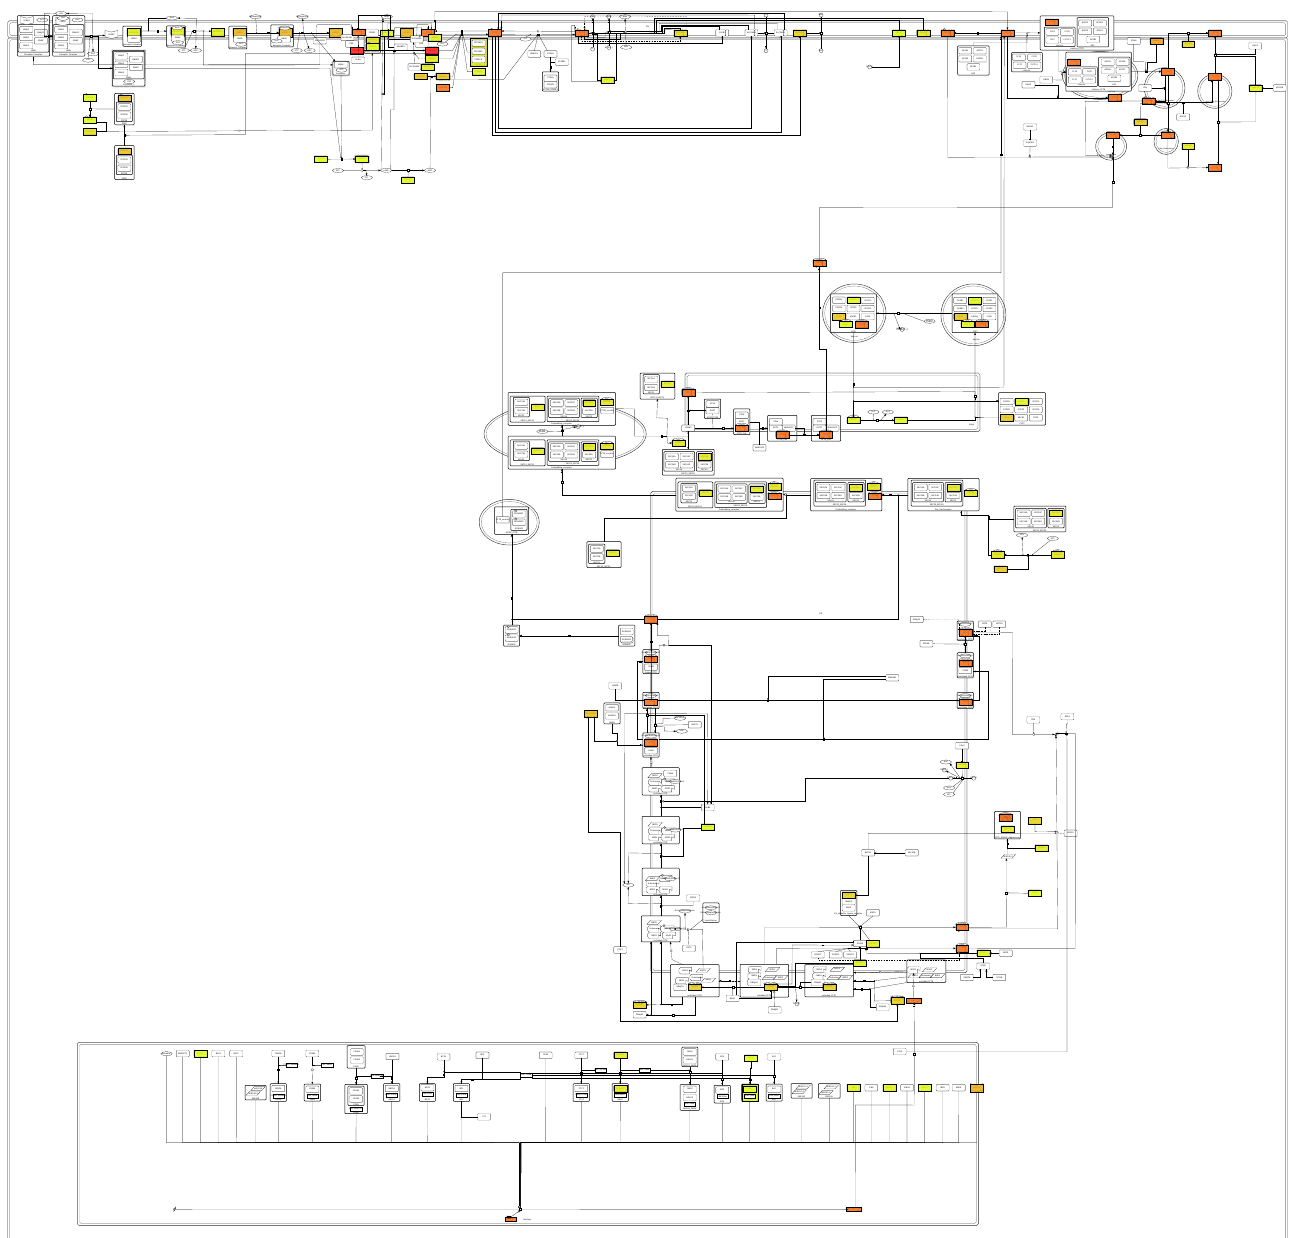
Figure 11. Combined results of all target identification approaches visualized in CFTR Lifecycle Map. The CFTR Lifecycle Map is an SBGN (Systems Biology Graphical Notation) representation of CFTR biogenesis in the cell. All proteins are shown as rounded rectangles. The colour represents the number of compounds associated with each target by all four approaches combined, ranging from one compound (yellow) to 120 compounds